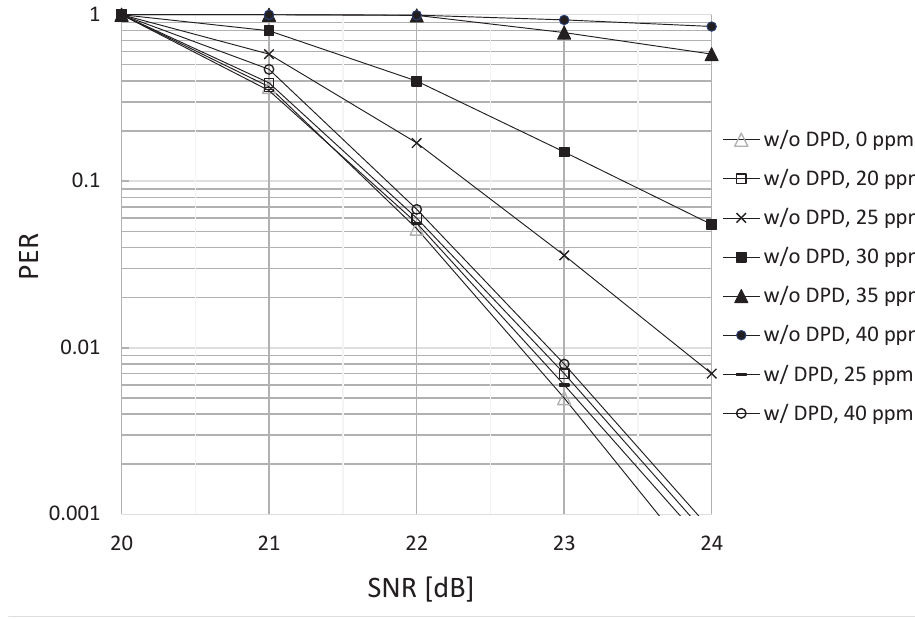
Figure 5. Training of digital predistorted carrier frequency offset; residual offset vs. frame